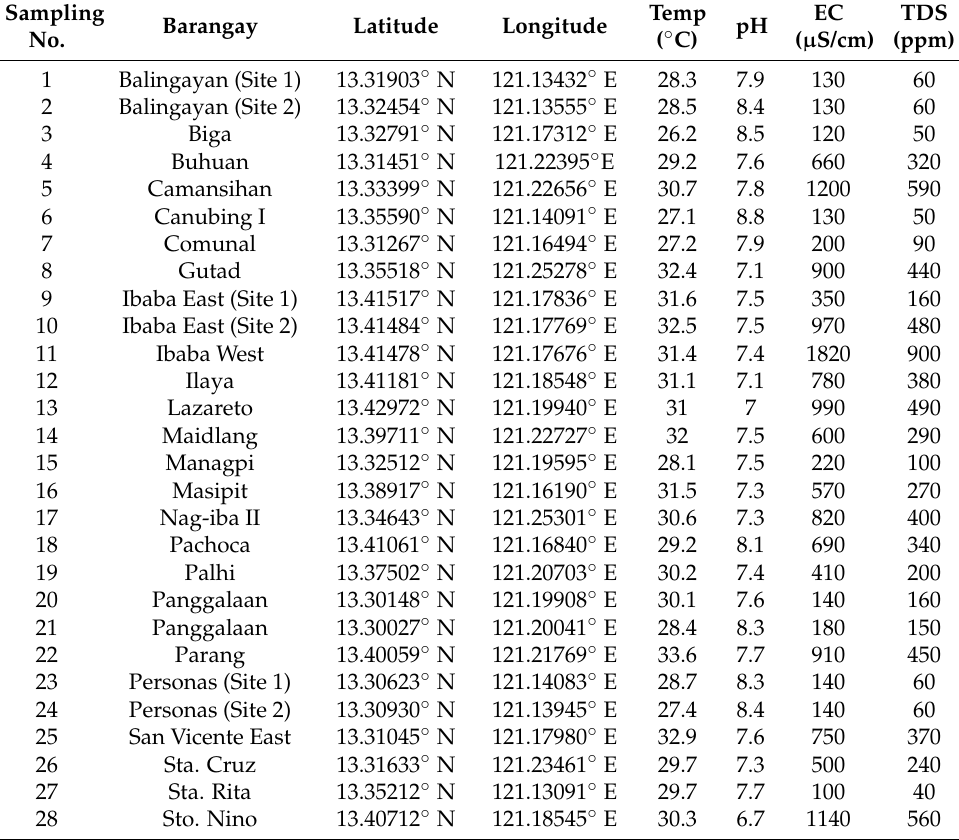
Table A1. Observed Physicochemical Properties of Groundwater